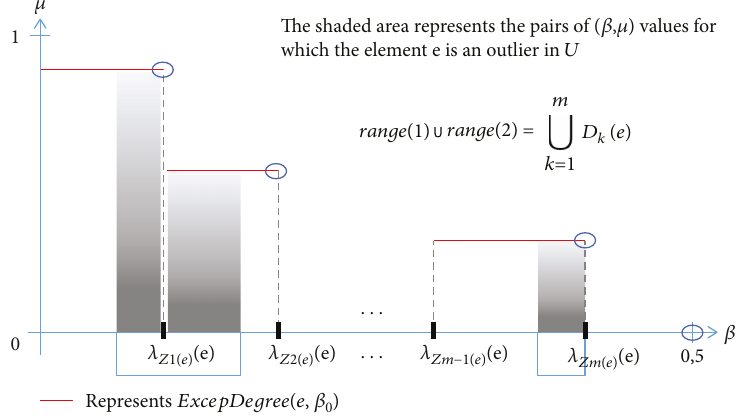
Figure 4: Range of β - μ values for which any element of the universe is an outlier in U